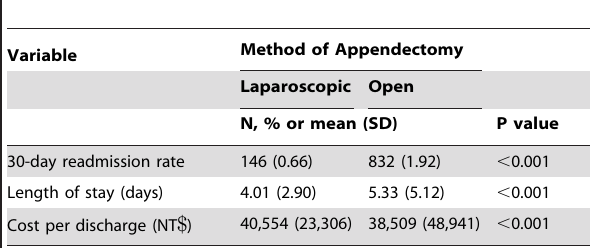
Table 2. Relationships between 30-day readmission rate, length of stay, cost per discharge, and the use of